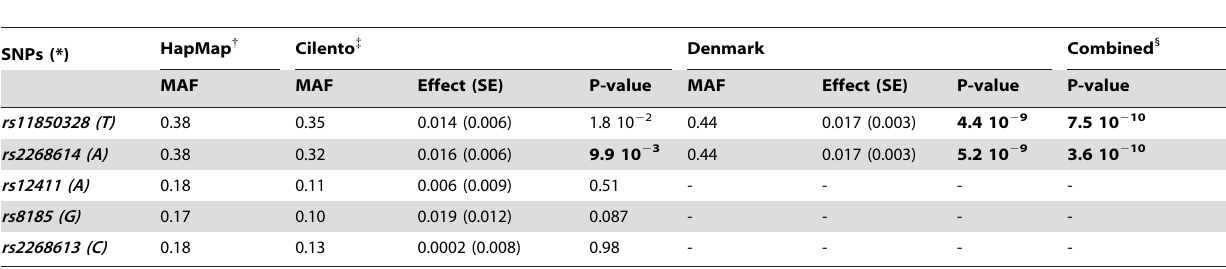
Table 2. Association results between the SNPs in the PGF gene and the protein levels according to the best fitting models for the Cilento and Denmark